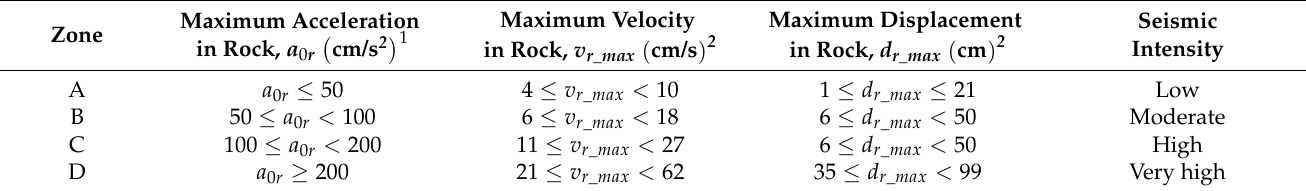
Table 1. Maximum acceleration, velocity, and displacement in the rock layer for each seismic zone,